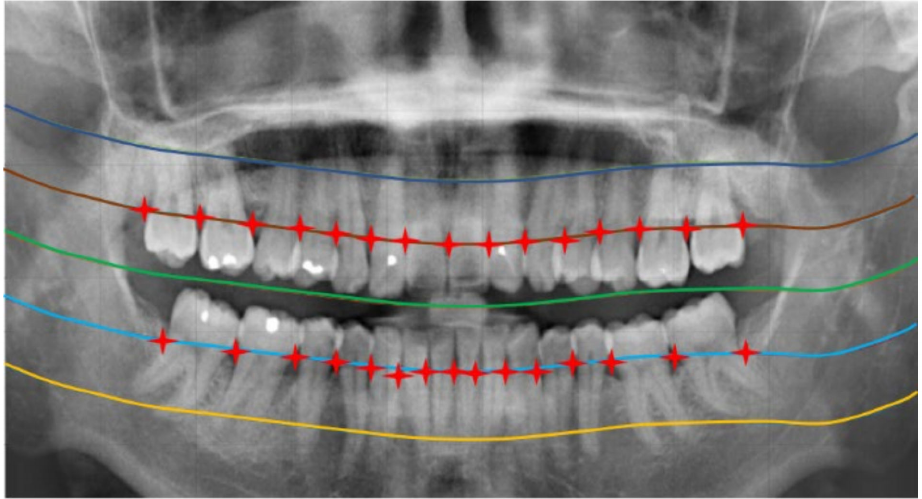
Figure 17. Markings showing the teeth